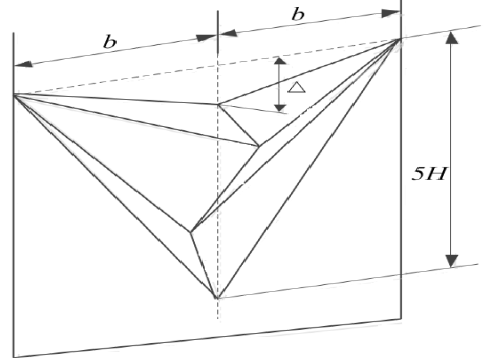
Figure 17. The assumed deformation mode for web crushing.